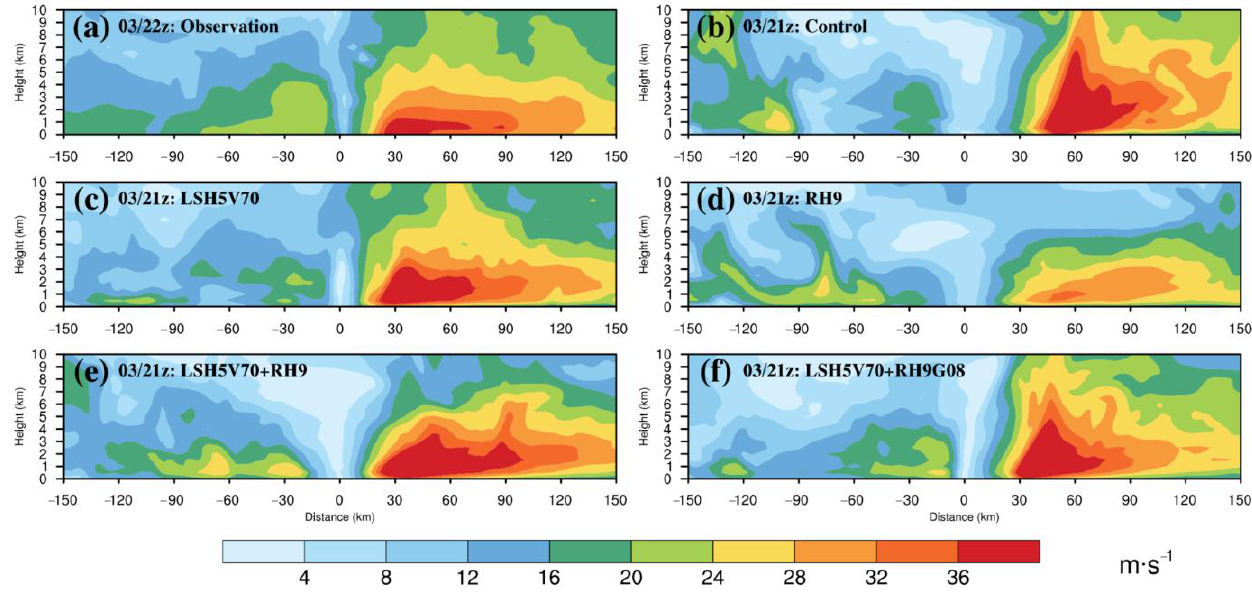
Figure 18. Wind field of a vertical cross-section of Earl at 2100 UTC 3 August 2016 from ( a ) NOAA Doppler radar, ( b ) Control, ( c ) LSH5V70, ( d ) RH9, ( e ) LSH5V70 + RH9, and ( f ) LSH5V70 + RH9G08.